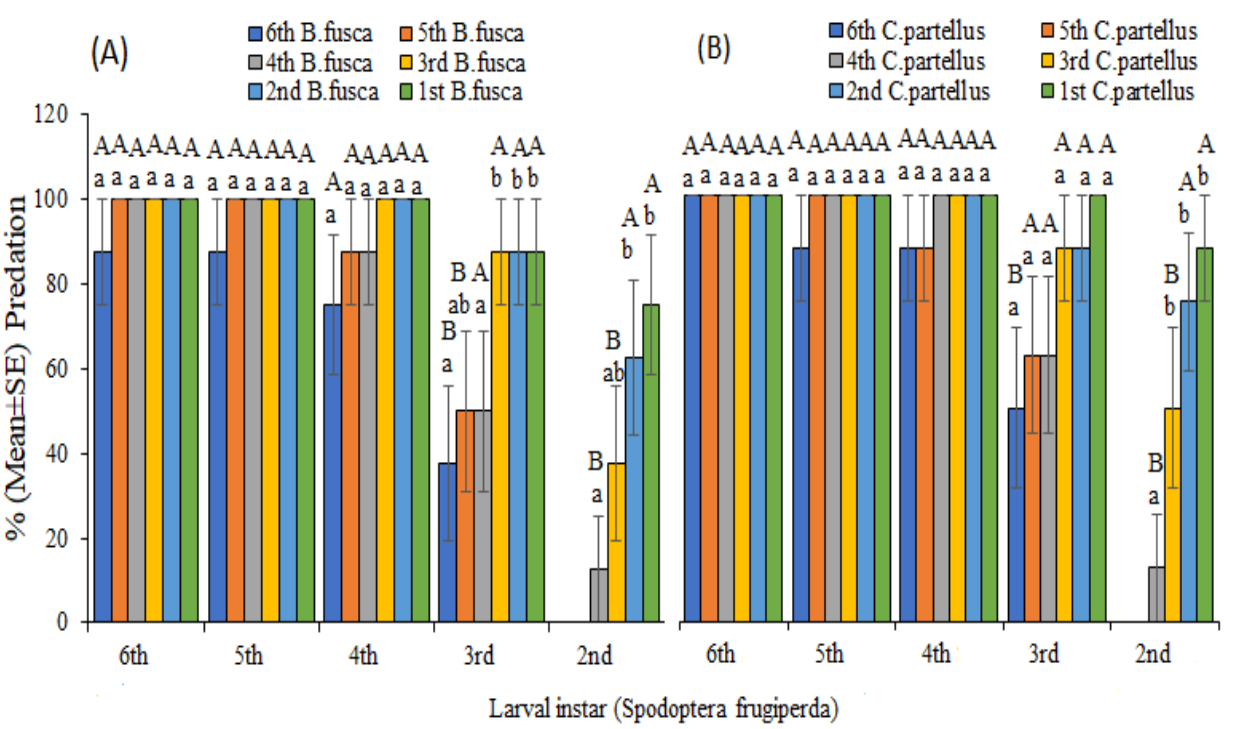
Figure 3. Predation rate (mean ± SE) of different larval instars of Spodoptera frugiperda on ( A ) Busseola fusca and ( B ) Chilo partellus in Petri dish experiment after 24 h feeding. Different uppercase letters above the error bars indicate significant differences in the predation rate of given larval instars of Spodoptera frugiperda across larval stages of stemborers, while different lowercase letters above error bars indicate significant differences in the predation rate of each larval development stage of Spodoptera frugiperda on all stemborer instars. Table 2. Percentage (mean ± SE) predation of Spodoptera frugiperda on Busseola fusca and Chilo partellus exposed together on maize plant and maize leaf in a Petri dish. Infestation % Predation of S.f on B.f % Predation of S.f on C.p